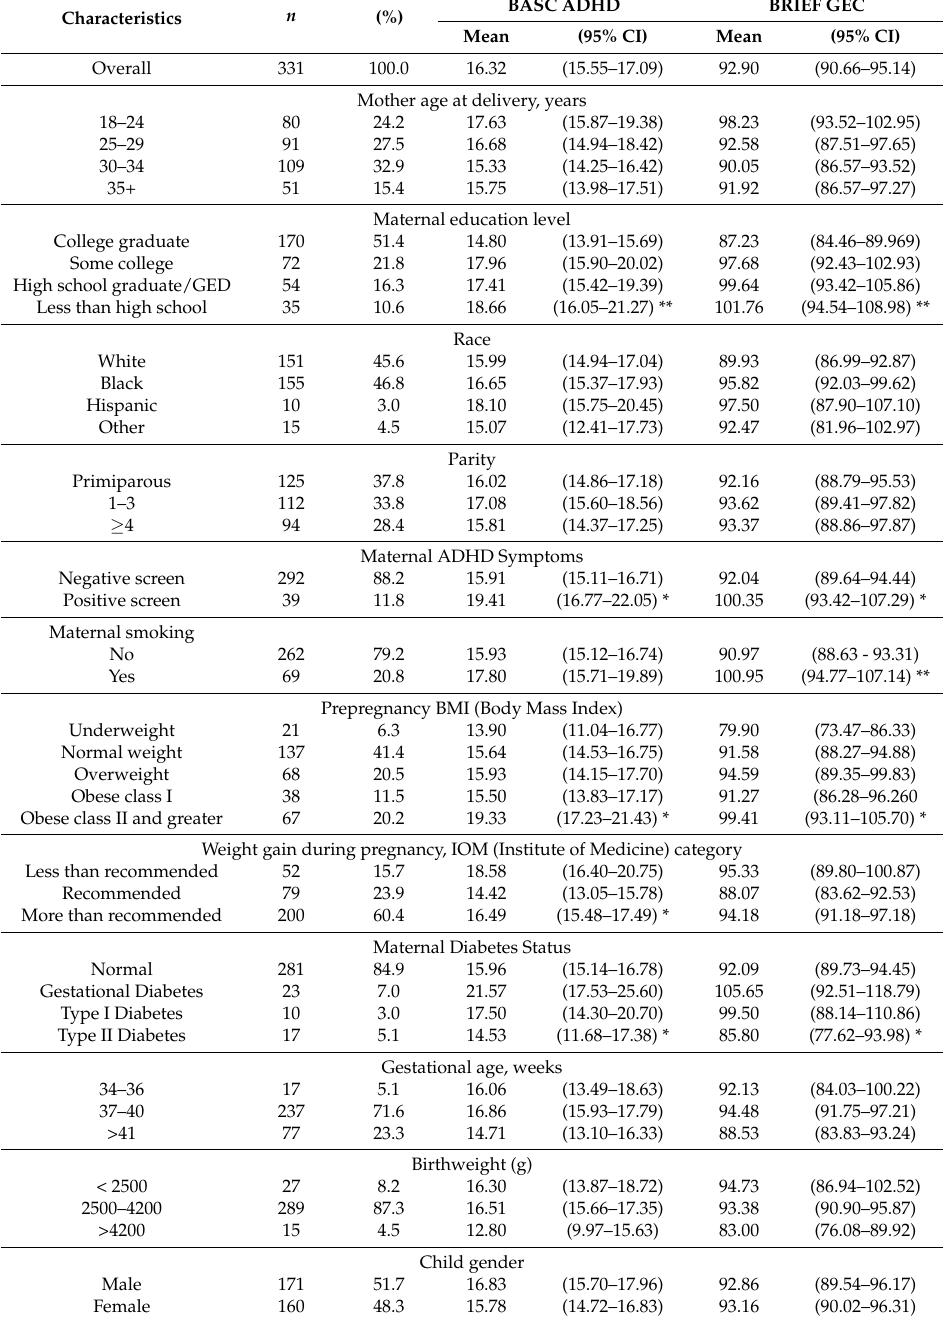
Table 1. Overall sample characteristics, BASC ADHD and BRIEF GEC by sample